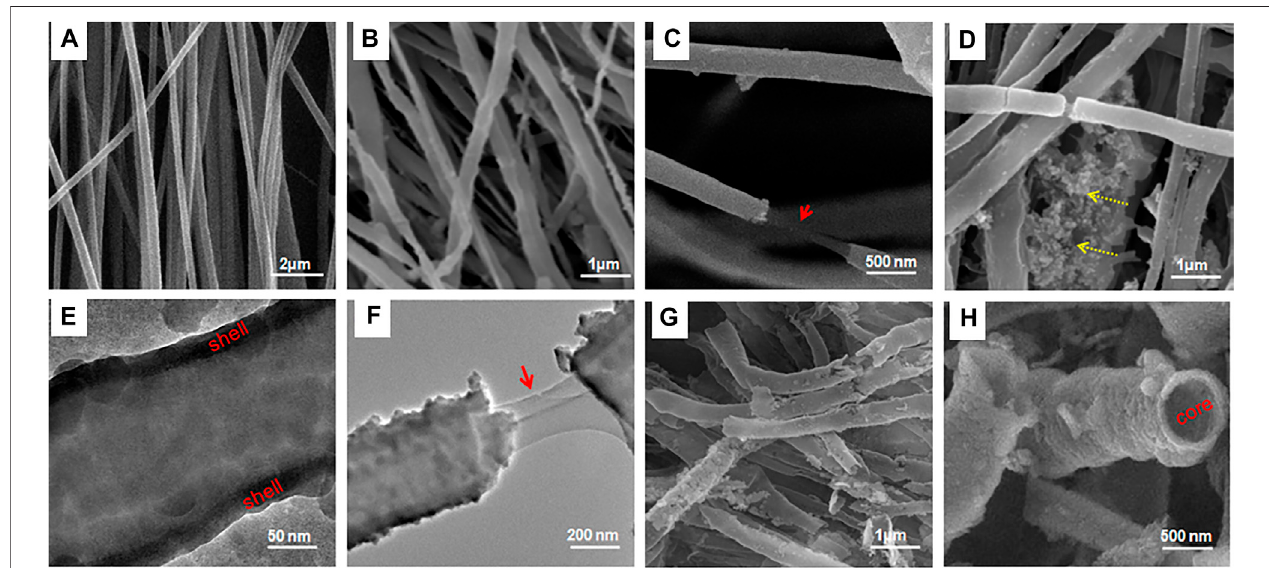
FIGURE 4 | Morphology and other characteristics of PCL@MS hybrid nano fi bers: (A − D,G,H) SEM and (E,F) TEM images of the samples. (A) PCL used as a template (422 ± 97 nm in size); (B) after one coating cycle, PCL@MS induced a homogeneous coverage of the silica layer on the surface; (C) morphology stretching showing the inner PCL (arrow) and outer silica layer; (D) when the coating cycle was exceeded (twice), some precipitates of the silica nanoparticles appeared (dotted arrows); (E) TEMimageclearlyshowingthesilicalayerforminguniformlyonthesurface(indicatedas “ shell ” ); (F) nano fi berstretchingrevealingtheinnerPCL(arrow) and the outer silica layer; (G,H) SEM image of the thermally treated PCL@MS, with complete removal of the inner PCL core (indicated as “ core ” ), revealing a hollow MS structure. Reprinted with permission from Singh et al. (2015). Copyright © 2015 American Chemical Society.